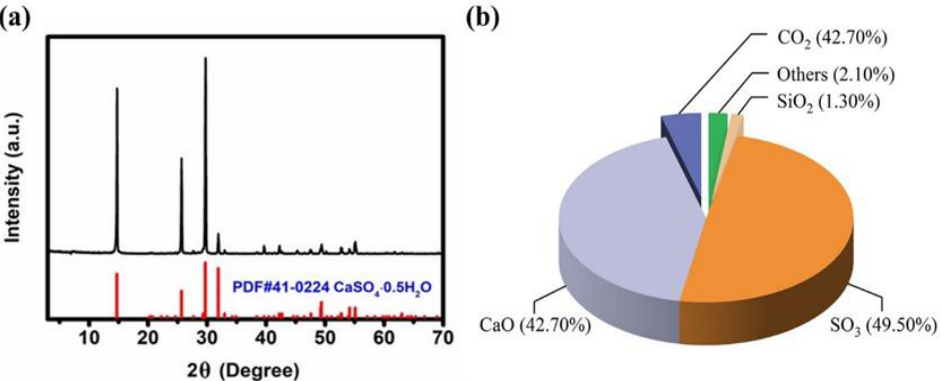
Figure 12. ( a ) XRD experimental results of α -dental gypsum (35 kV (30 mA) −1 , 8° min −1 , 0.02° step −1 ), ( b ) main chemical composition.